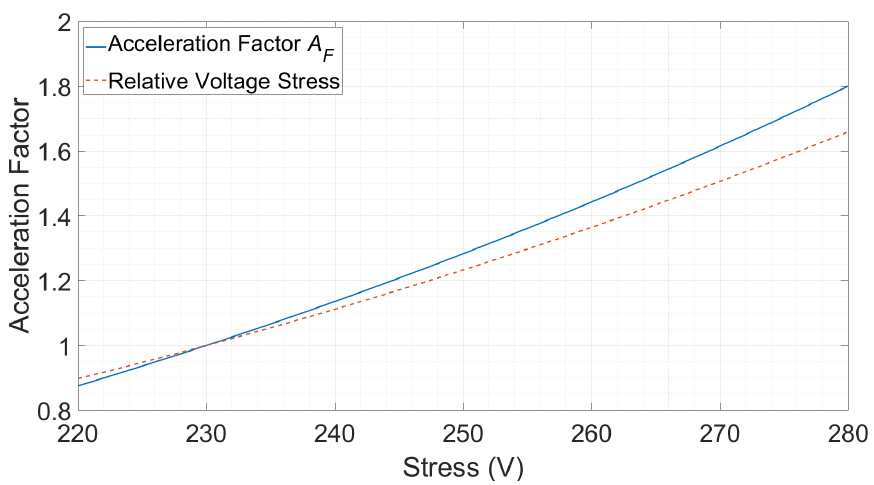
Figure 11. Acceleration Factor ( A F ) due to Voltage (this study) and Relative Voltage Stress from [29]. To accurately quantify the impact that voltage has on the lifetime of a rated device, the inverse power law (IPL) stress model was applied. This is a common stress model used for ALT when the acceleration stress is non-thermal [30]. Whilst the capacitors were exposed to an elevated temperature, the stress factor of interest for this study was the operating voltage. The IPL uses (4) to determine the expected life of a